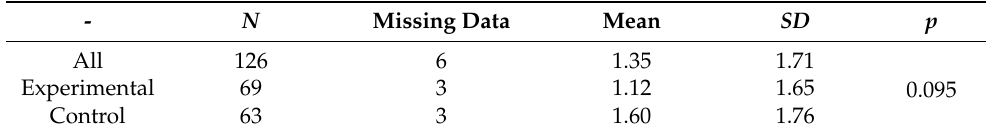
Table 4. VAS-A scores provided by the children.